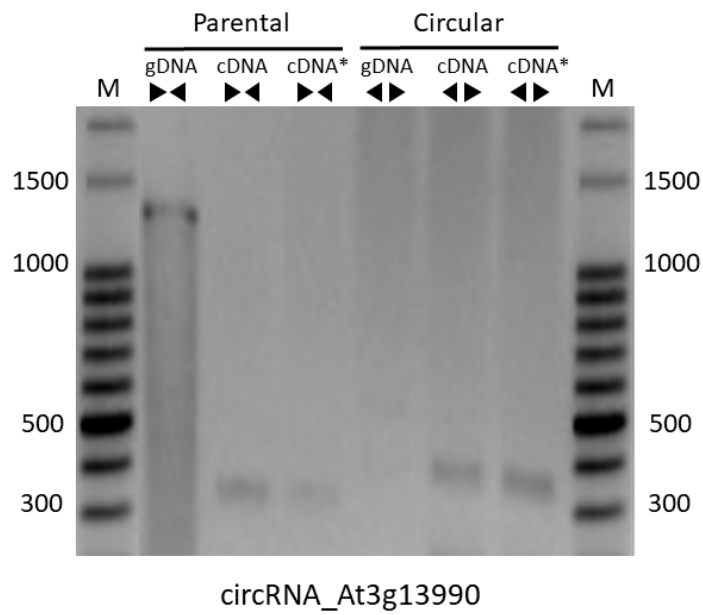
Figure 2. Validation of circRNA by RT-PCR. PCR reactions were performed using divergent primers ( ) to amplify the circRNA_At3g13990. Convergent primers ( ) were used to amplify parental mRNA. Genomic DNA (gDNA) was used as control. Samples were analyzed on 1,5% agarose gel. (M) DNA size marker of 100 bp; cDNA: complementary DNA; cDNA*: complementary DNA produced from total RNA treated with RNase R previously to reverse transcription. bp: base pairs.